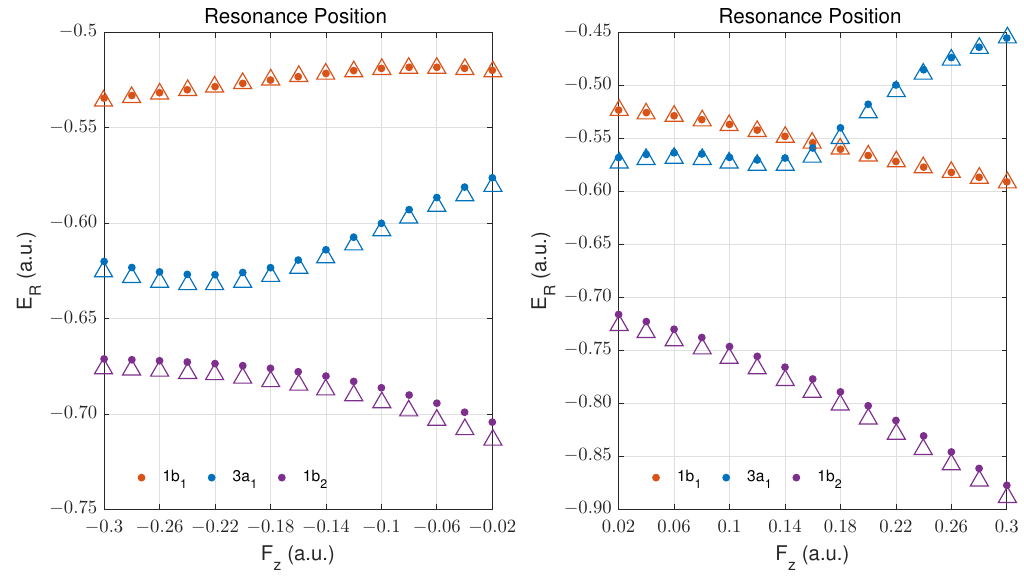
Figure 9. Resonance positions for the three valence MOs exposed to a field aligned ( left panel ) and counter-aligned ( right panel ) with the molecular axis, where F z > 0 corresponds to a force experienced by the electron in the positive z direction. The solid dots are for calculations with (cid:96) max = 3 and the triangles with (cid:96) max = 4.